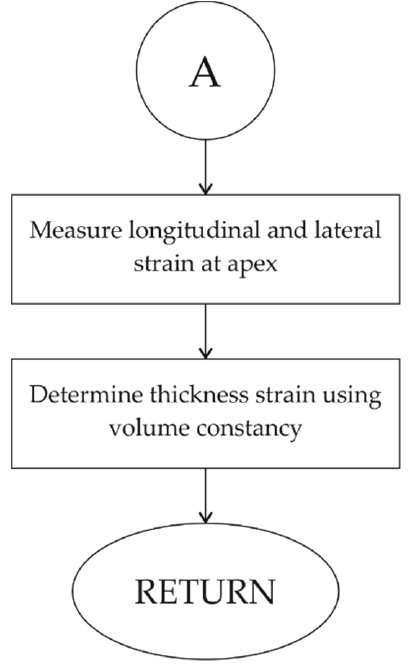
Figure A2. Apex strains for specimens without coarse necks.